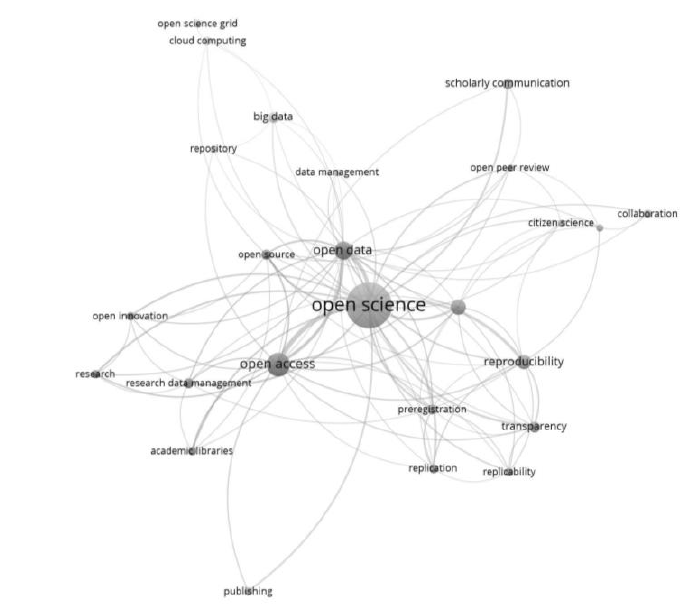
Fig. 5 The network of keywords of the publications on Open Science (1979-2020). Source: